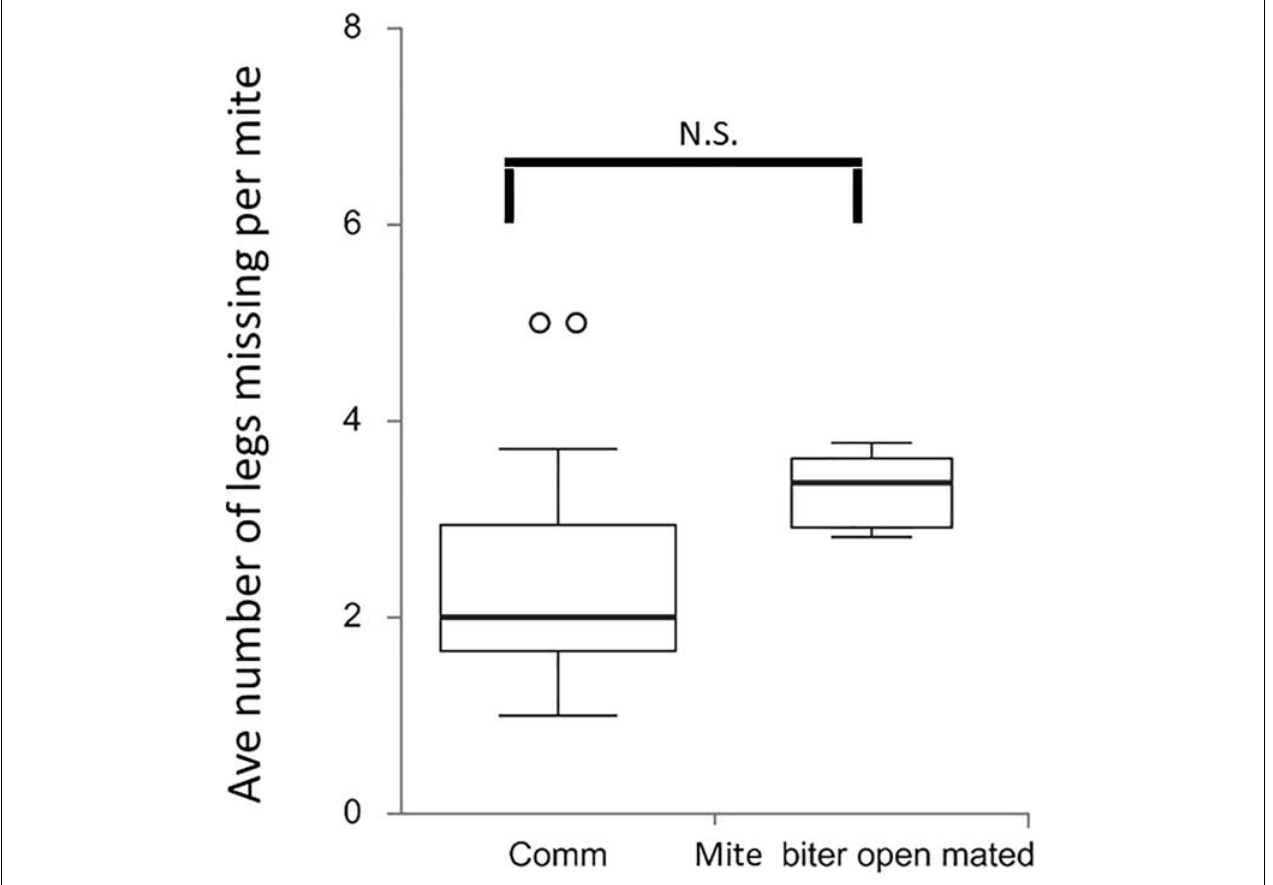
FIGURE 6 | Six parameters of the scanned mandible are listed on the microCT image. L, length; W, width; H, height; SE, short edge; LE, long edge; S, span of the spine